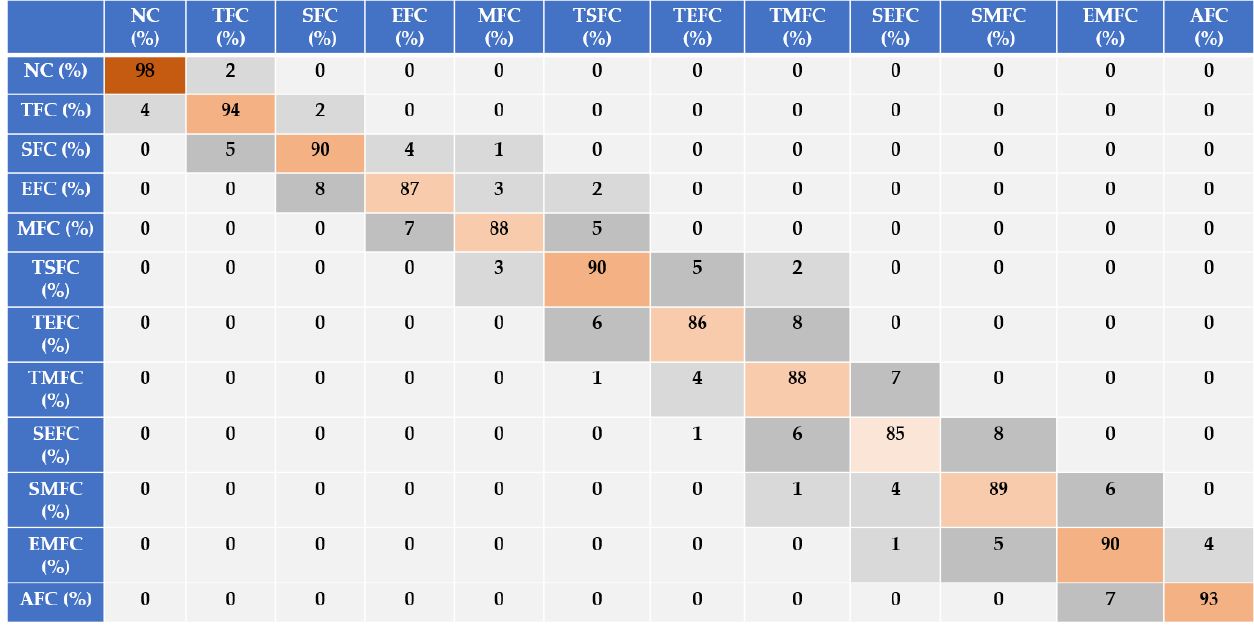
Figure 10. Sensor-fault-classification accuracy using FGAL-CR and an SVM.